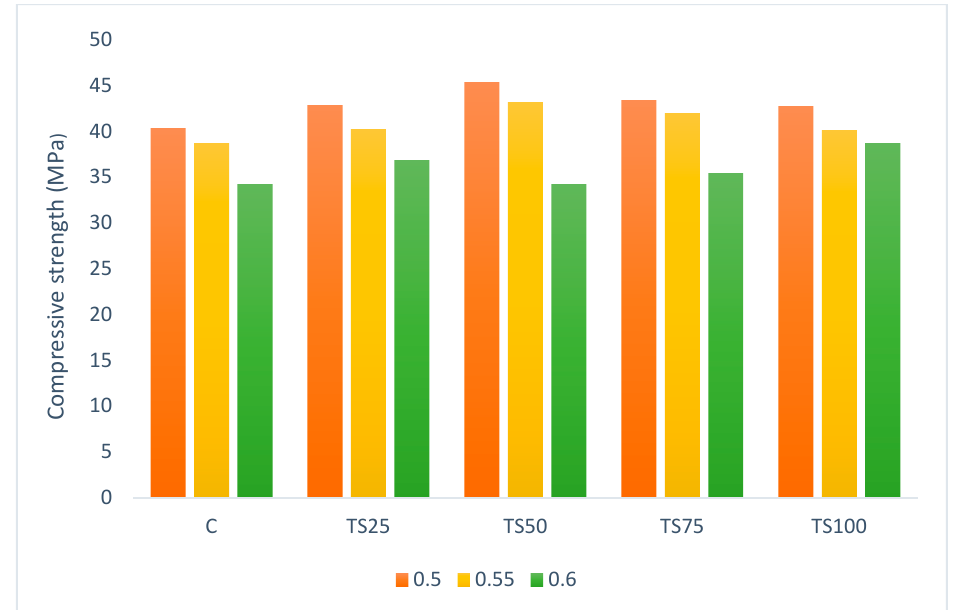
Figure 10. The compressive strength of graded TS at different w / c ratios.